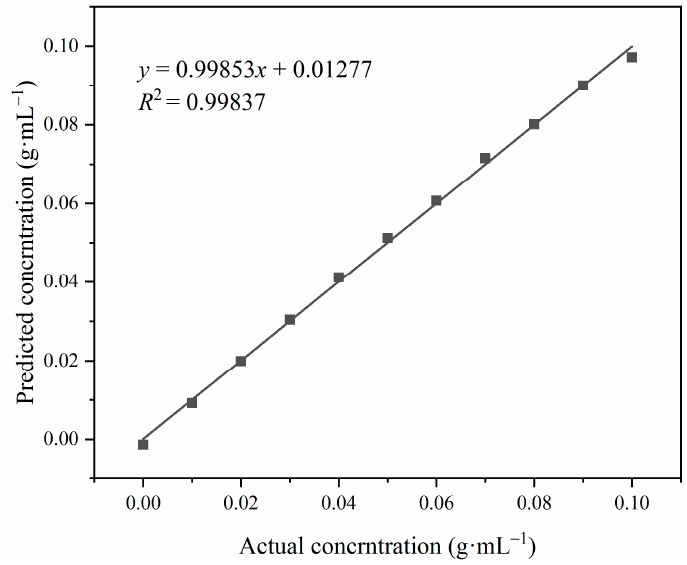
Figure 12. Calibration model of ATR-FTIR spectroscopy of sacubitril.